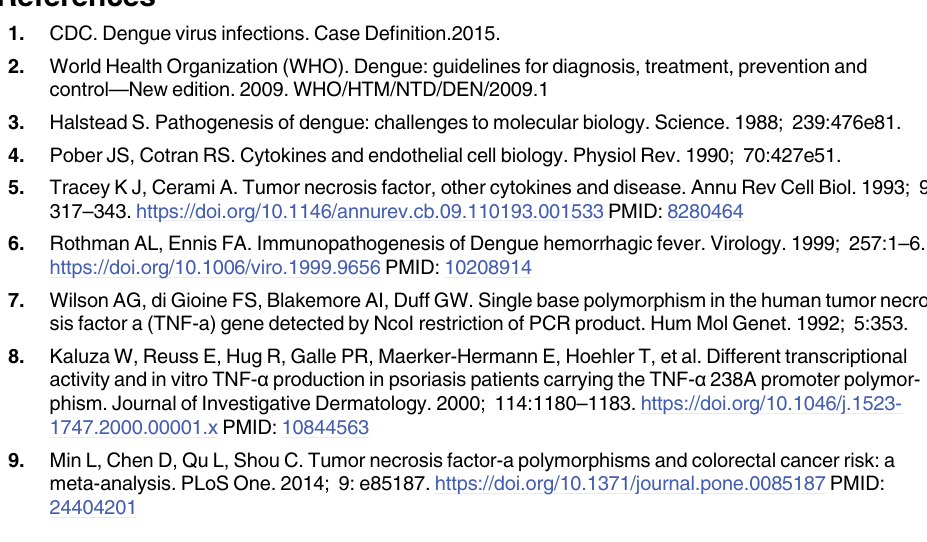
S3 Table. The excluded studies and reasons for exclusion. S4 Table. The methodological quality of the included studies. S5 Table. Sensitivity analysis of the allelic model using the WHO 1997